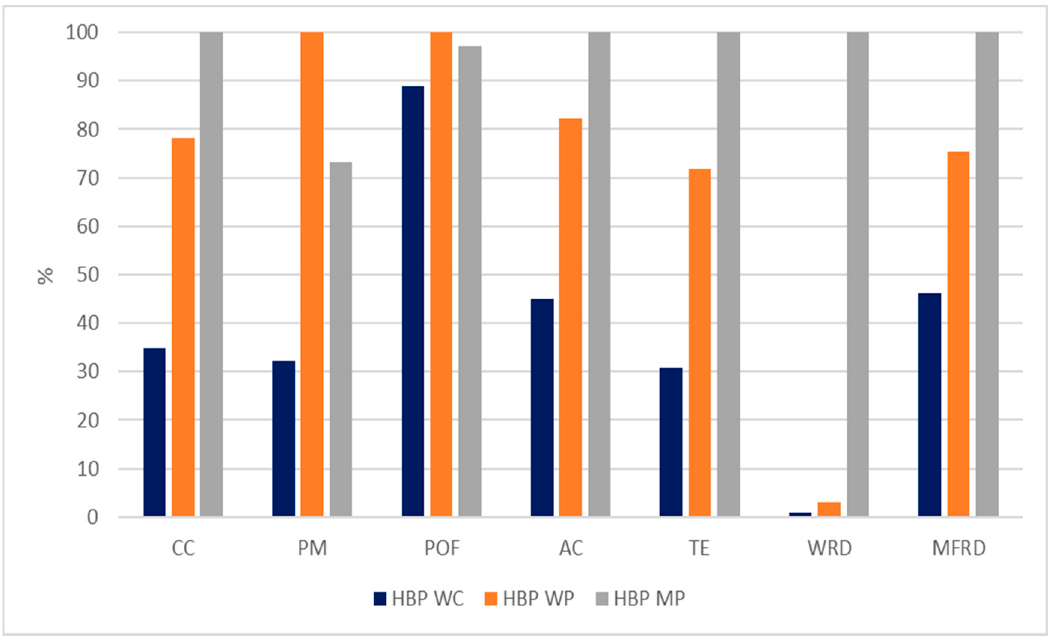
Figure 4. HBP technology fueled with various biomass fuels (the same graph applies to both 1 MJ heat or 1 kWh electricity). Values are normalized taking as 100% the impacts of the most impacting scenario. CC = Climate change, PM = Particulate matter, POF = Photochemical ozone formation, AC = Acidification, TE = Terrestrial eutrophication, WRD = Water resource depletion, MFRD = Mineral, fossil, and renewable resource depletion. WC = wood chips, WP = wood pellets, MP = Miscanthus pellets.